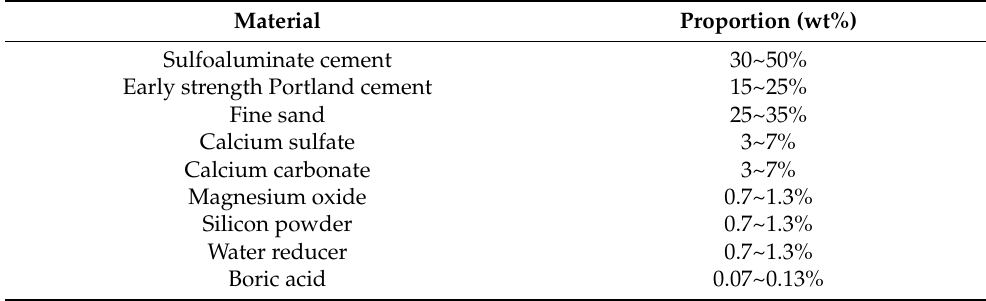
Table 1. The raw materials composition of HSFCM.